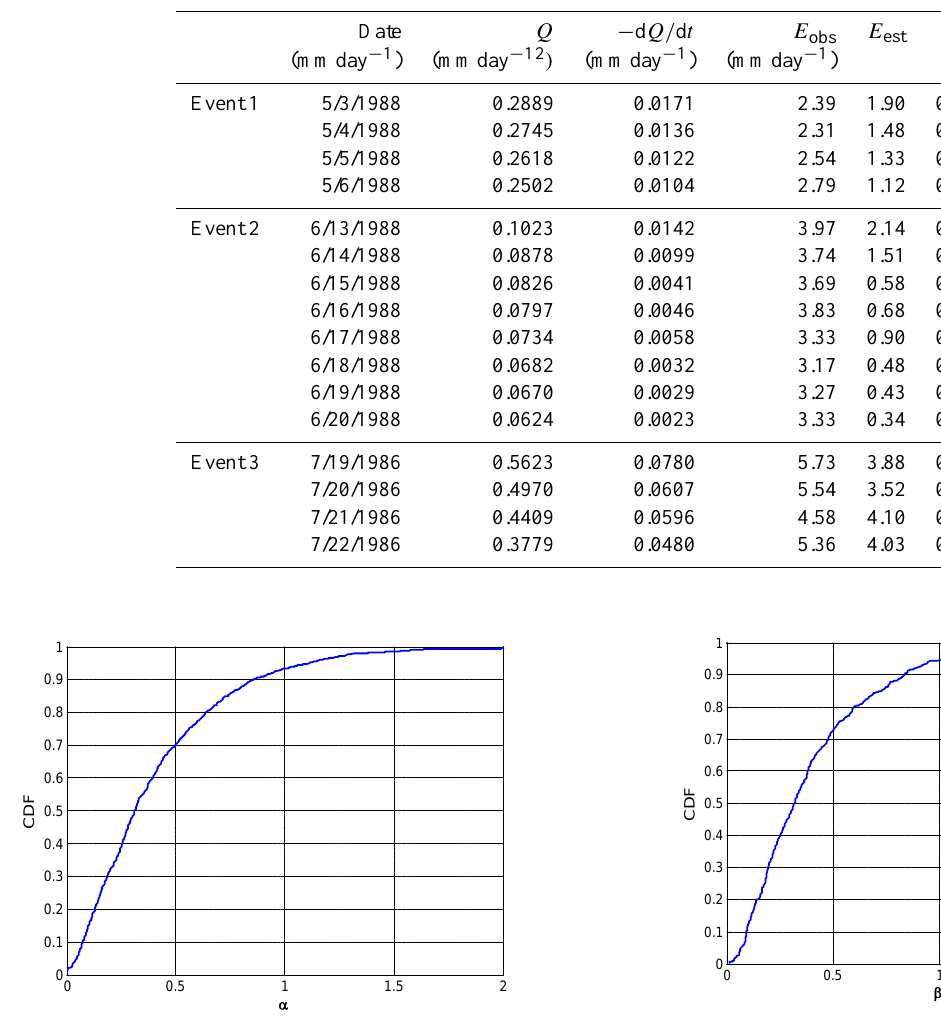
Fig. 6. Cumulative distribution function of α for all of the study watersheds.